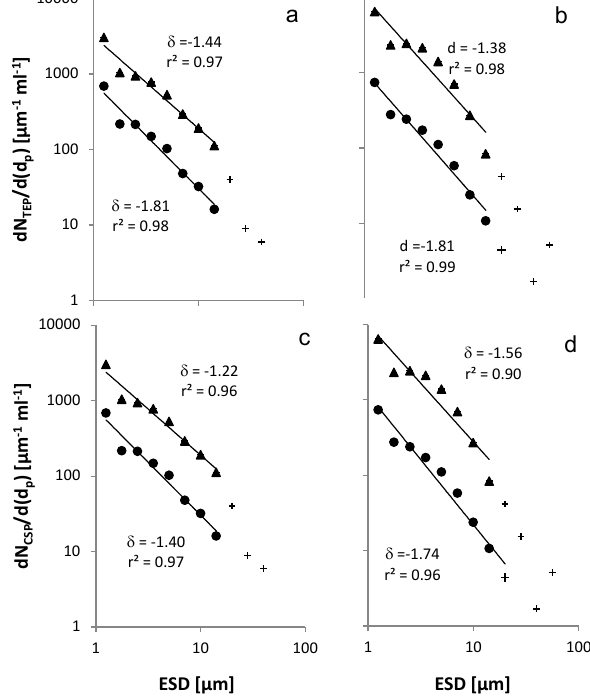
Figure 5. Size–frequency distribution of gel particles. Calculation of the size–frequency distribution slope exemplified for TEP, aver- aged for all mesocosms on day 1 (circles) and 8 (triangles) during Varied P (a) and Varied N (b) , respectively, and for CSP on day 2 (circles) and 8 (triangles) during Varied P (c) and Varied N (d) . Linear regression of log[d N/ d (d p ) ] versus log[ d p ] was fitted to the particles in the size range of 1.05–14.14µm ESD (solid